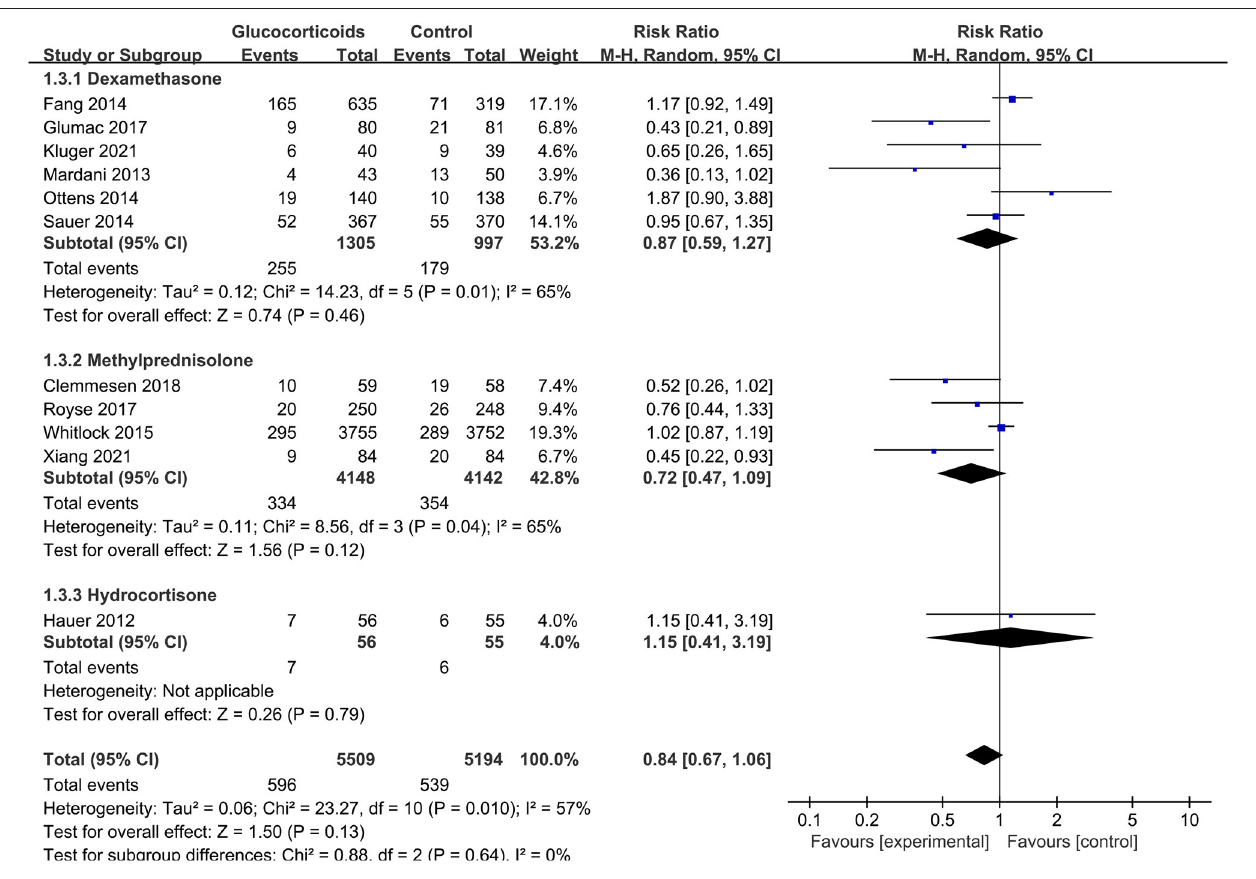
FIGURE 6 | Subgroup analysis of the incidence of PNDs for the type of glucocorticoids.